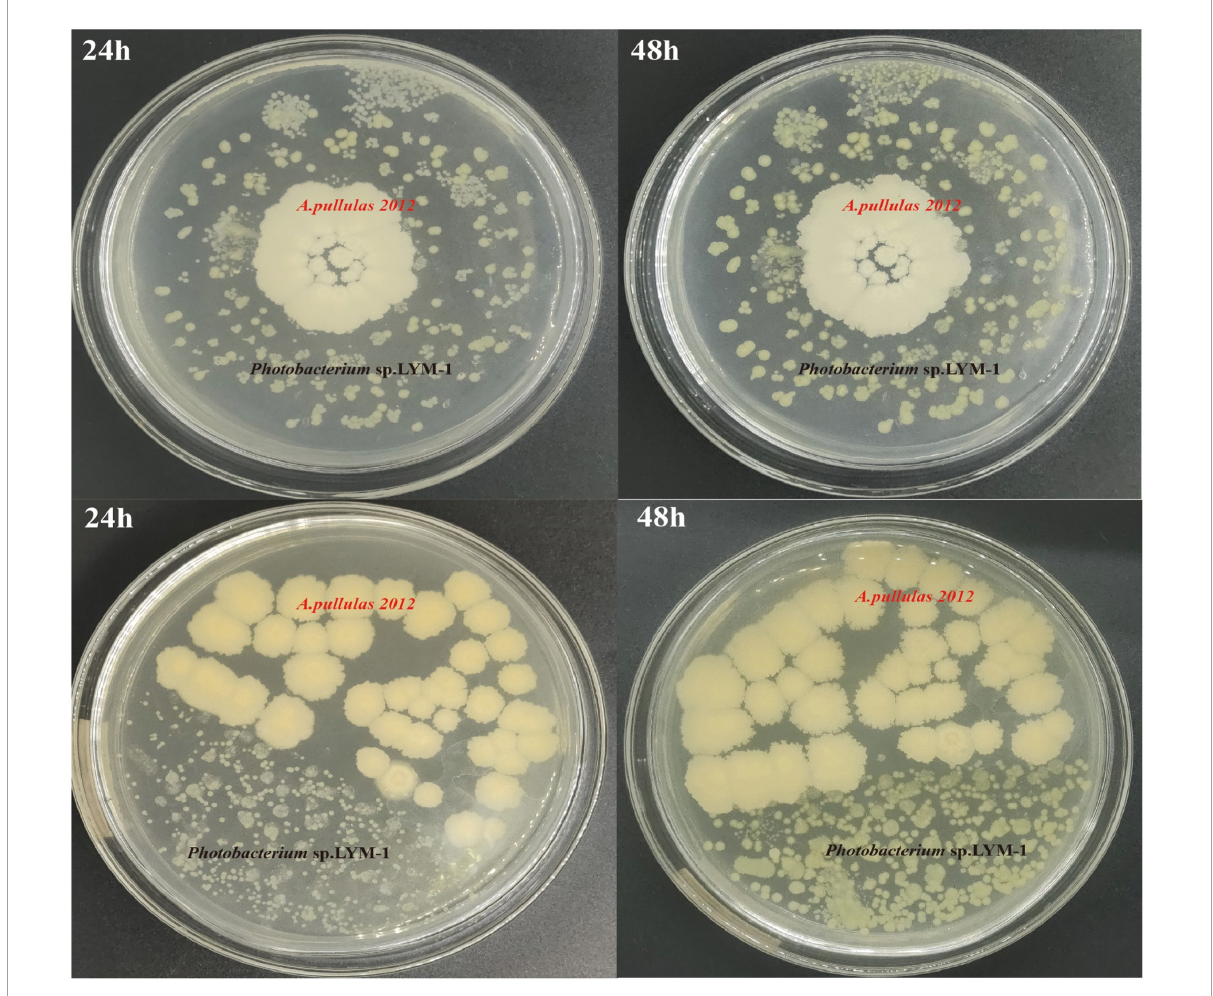
FIGURE2 Compatibility result of Photobacterium sp. LYM-1 and A. pullulans 2012.